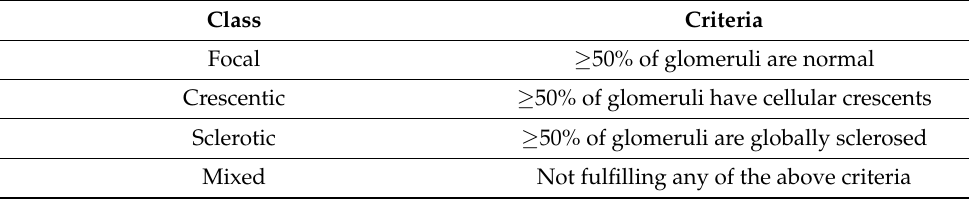
Table 2. Classification of ANCA-associated glomerulonephritis *.